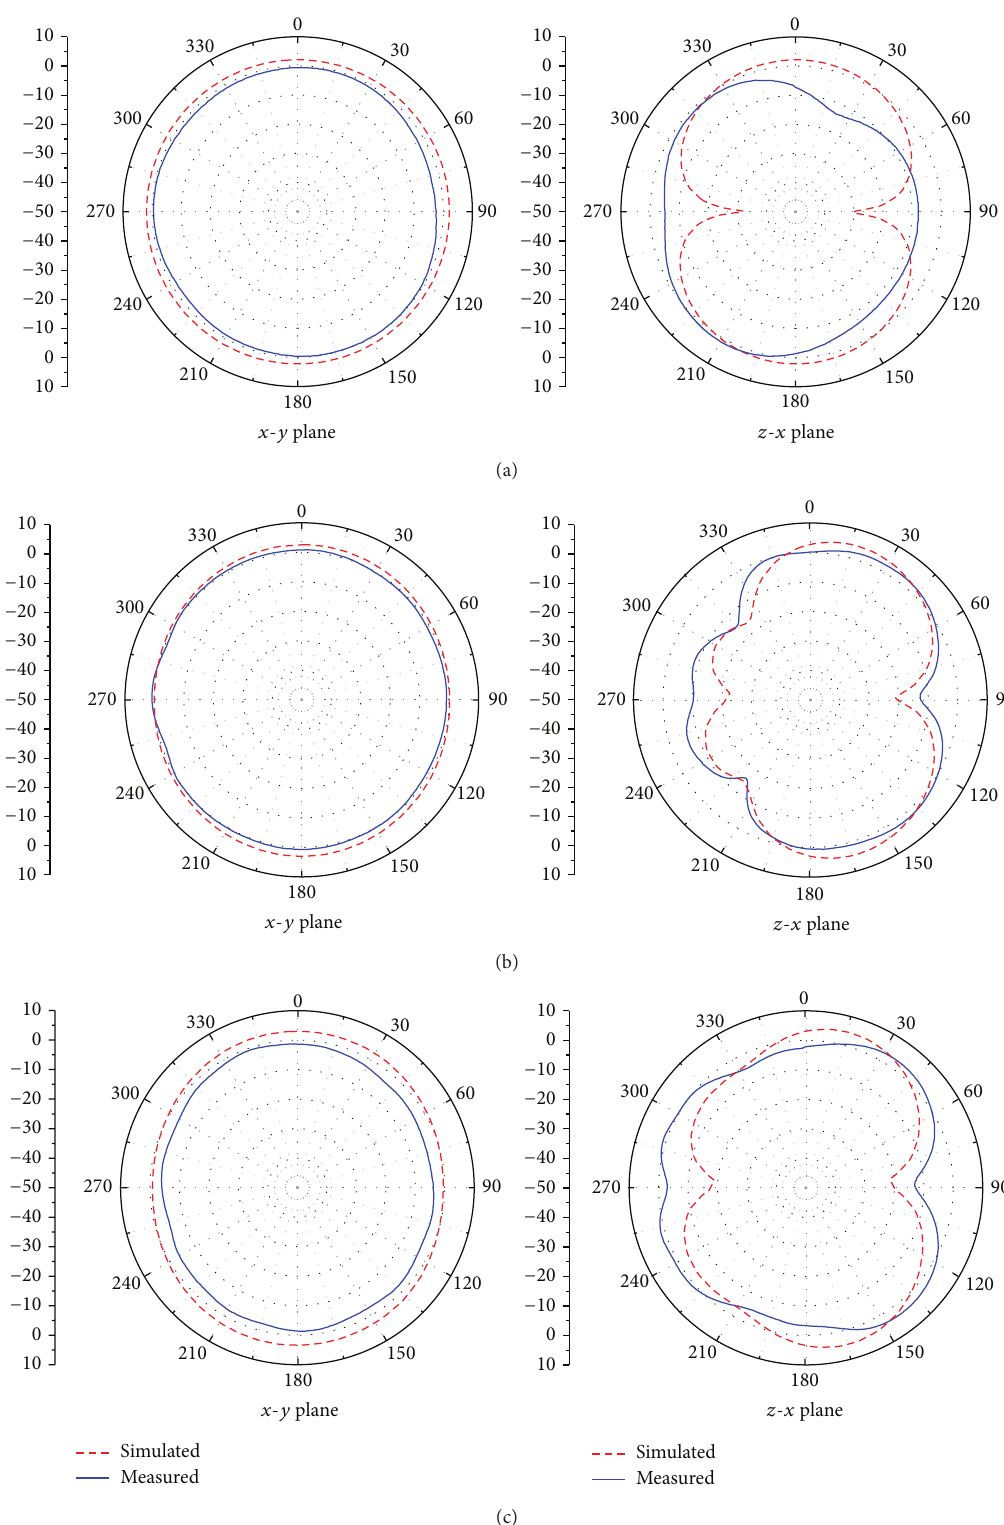
Figure 5: Simulated and measured radiation patterns of the proposed antenna at (a) 2.4GHz, (b) 5.2 GHz, and (c) 5.8